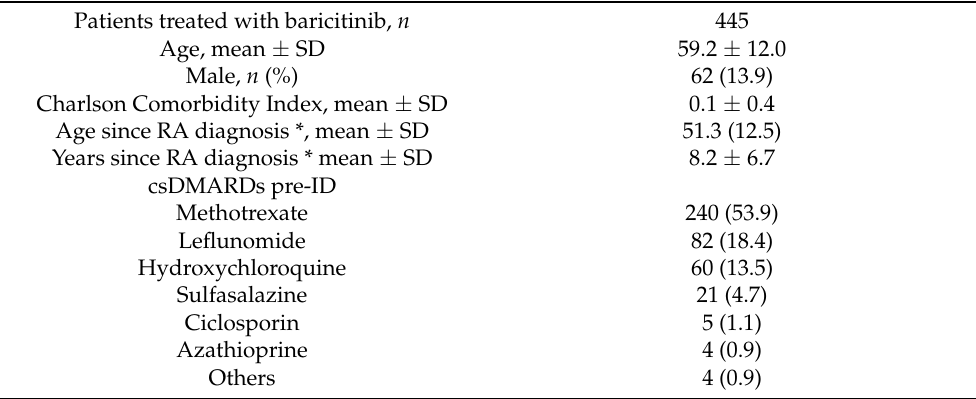
Figure 1. Treatment patterns of the included RA patients for the calendar year 2019. The first line refers to Table 2019, while the second line refers to treatments observed during follow-up. Abbreviations: RA, rheumatoid arthritis; csDMARDs or bDMARDs, conventional synthetic or biologic disease-modifying antirheumatic drugs; NSAIDs, nonsteroidal anti-inflammatory drugs; CS, corticosteroids. Table 1. Clinical, demographic characteristics and previous use of csDMARD in the baricitinib cohort.